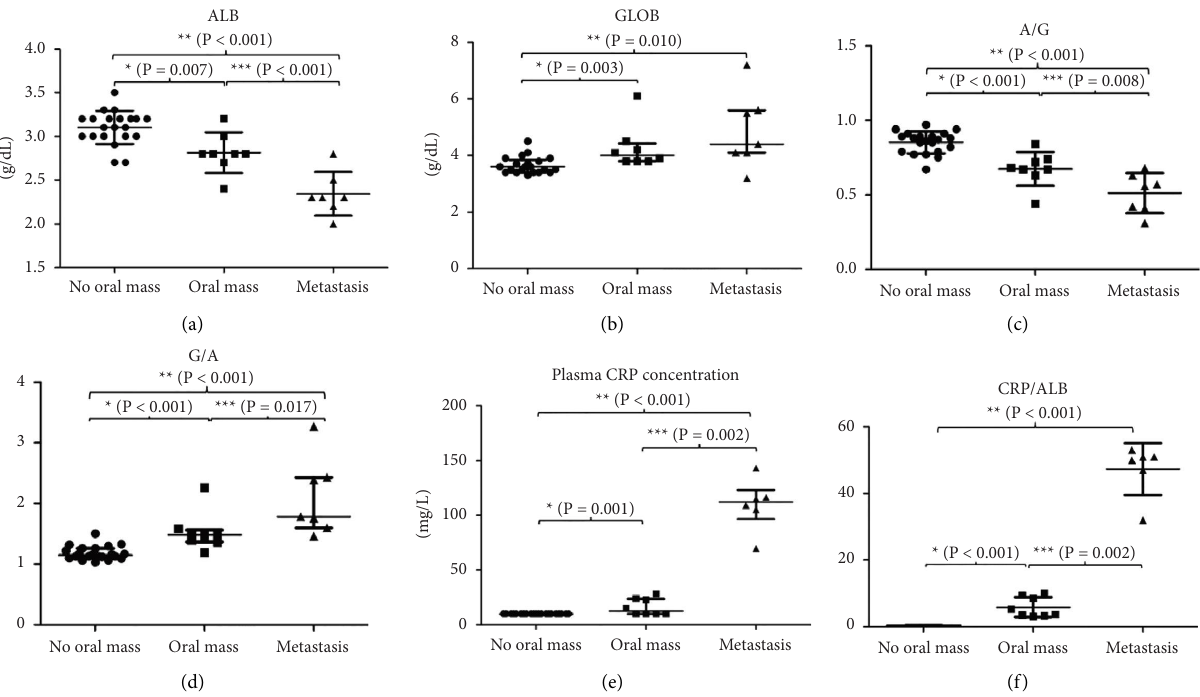
Figure 5: Comparison of the plasma albumin concentration (ALB, mean ± SD)(a), plasma globulin concentration (GLOB, median (IQR))(b), albumin to globulin ratio (A/G, AGR mean ± SD)(c), globulin to albumin ratio (G/A, GAR, median (IQR))(d), plasma CRP concentration (CRP, median (IQR))(e), and CRP to ALB ratio (CRP/ALB, CAR median (IQR))(f) of dogs among the no oral mass group, the oral mass group, and the metastasis